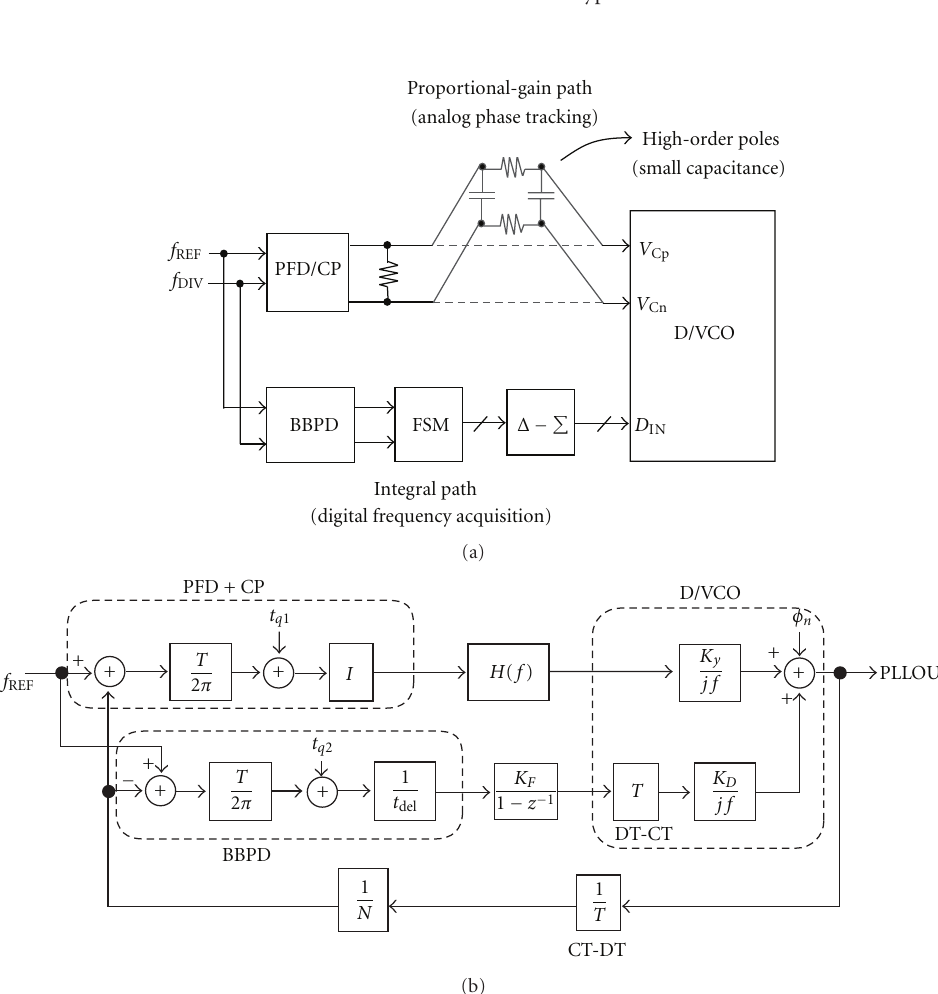
Figure 4: (a) Basic concept and (b) linear